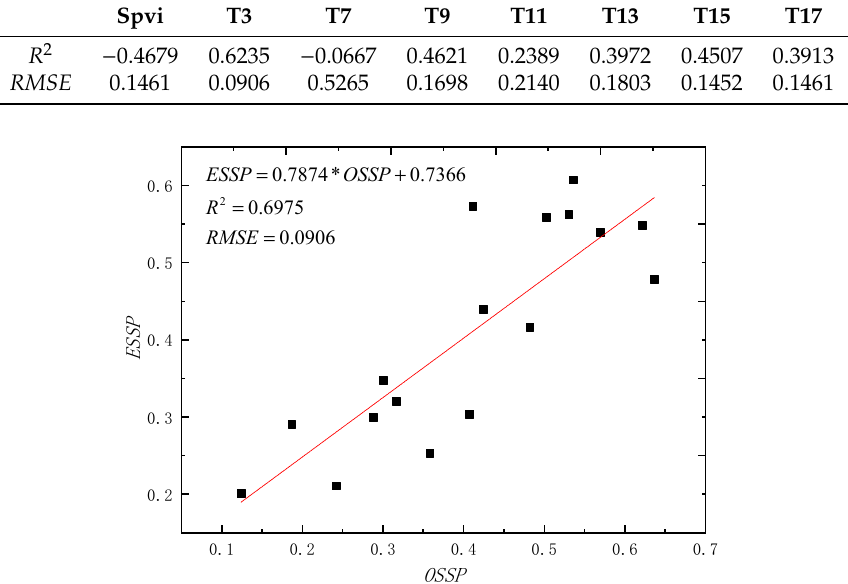
Figure 4. Relationship between simulated values and observed values of the mind evolutionary algorithm-back propagation neural network model based on the T3 feature factor subset. The T3 is a subset of textural feature factors based on the 3 × 3 calculation window. Note: observed (OSSP) and estimated spatial structural parameters (ESSP) (* represents multiplication).